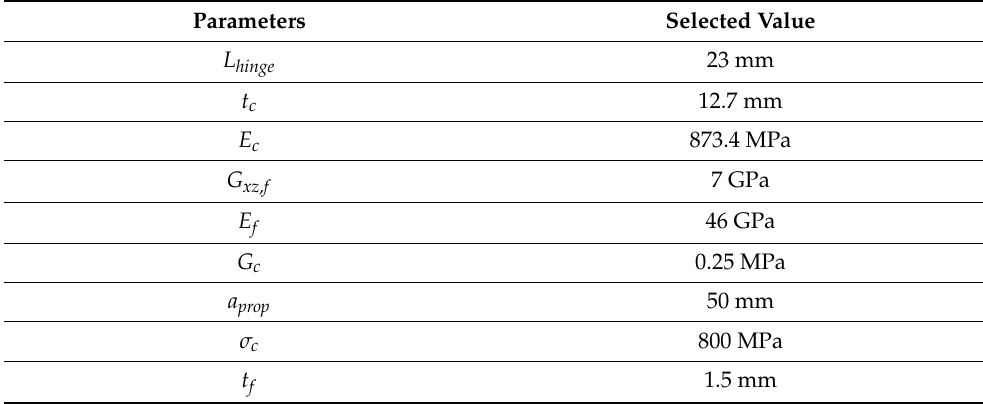
Table 1. Selected parameters for SCB specimen sizing. Parameters Selected